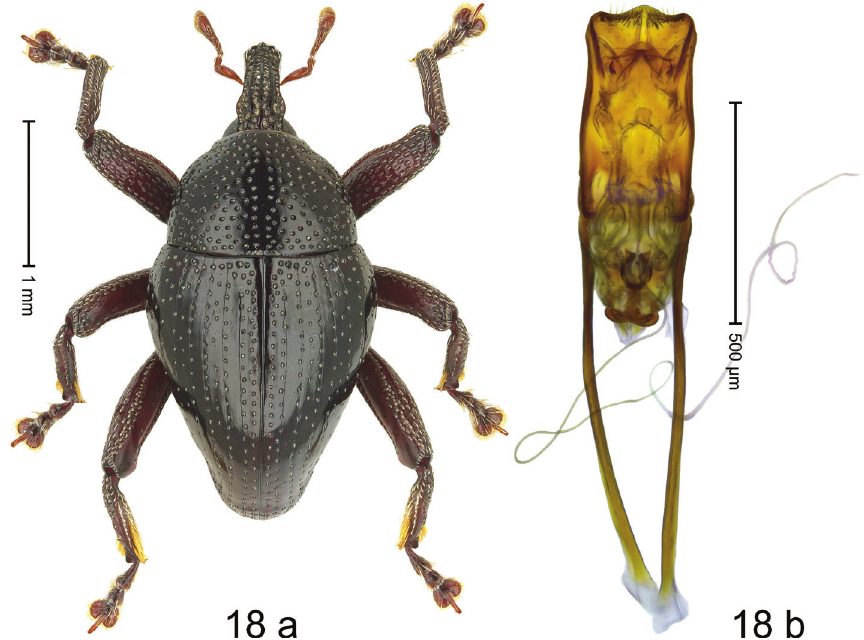
Figure 18. Trigonopterus puspoi sp. nov., holotype a habitus b penis.